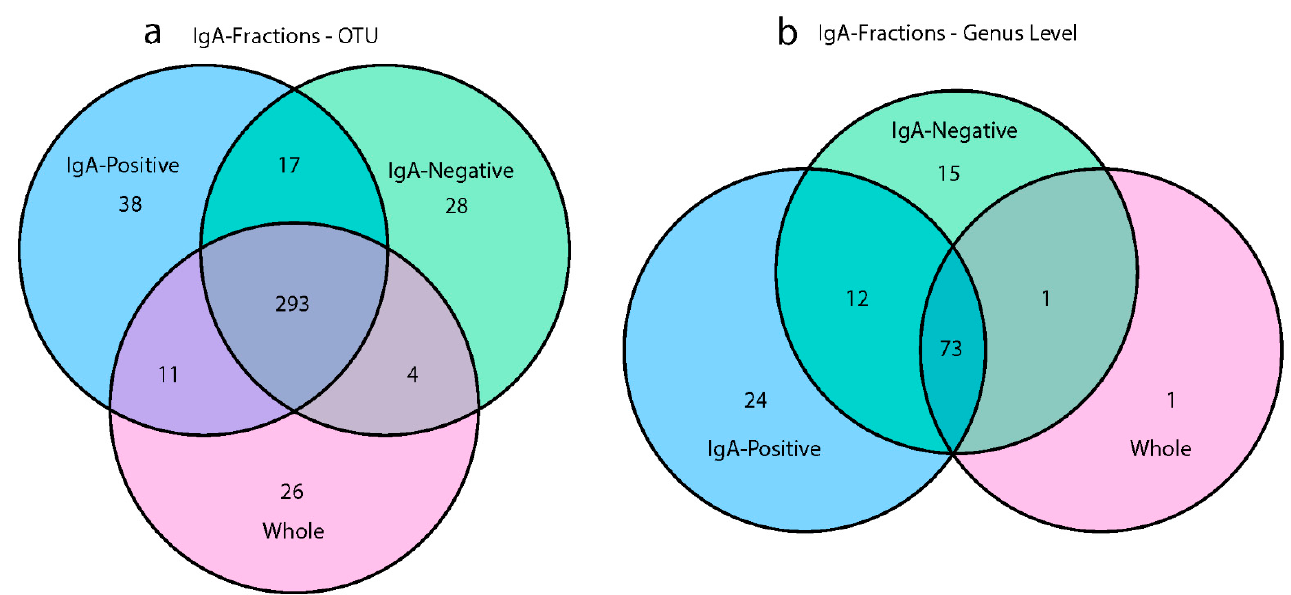
Figure 5. Shared and unique bacteria in different microbiome fractions. Venn diagrams represent the number of ( a ) OTUs or ( b ) genera found in the three microbiome types (i.e., whole, IgA positive, and IgA negative). Data are based on the cumulative sum scaling normalized counts for each OTU.